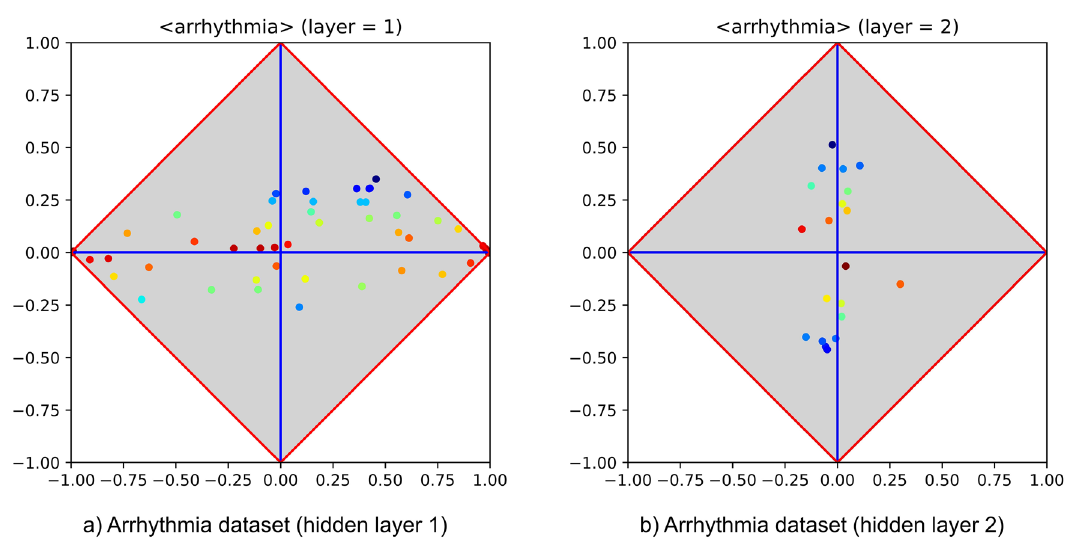
Figure 6. Inner behaviour of an MLP, trained with PT, on the arrhythmia dataset (from UCI). The two hidden layers (with 50 and 20 hidden units, respectively) are entrusted with very different tasks: the one whose class signature is shown at the left-hand side basically performs feature extraction, whereas the other (right- hand side) is responsible for